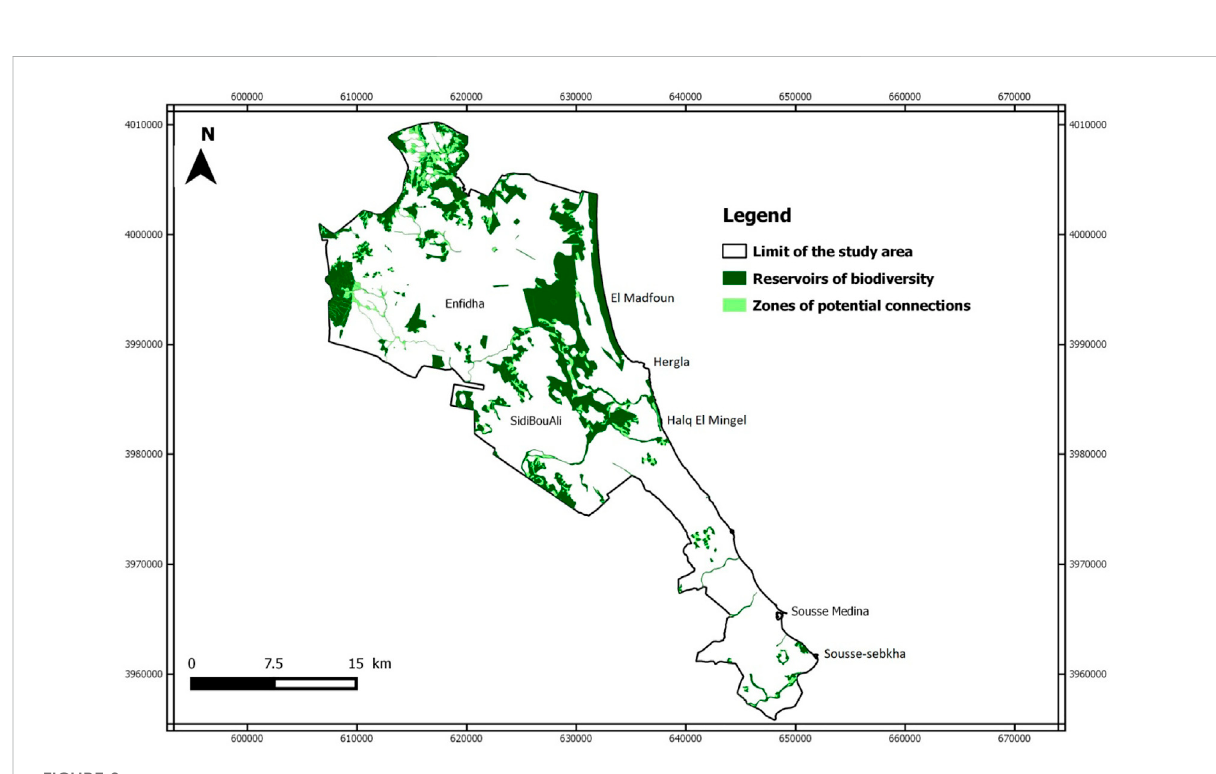
FIGURE 9 Potential connections of the forest habitat